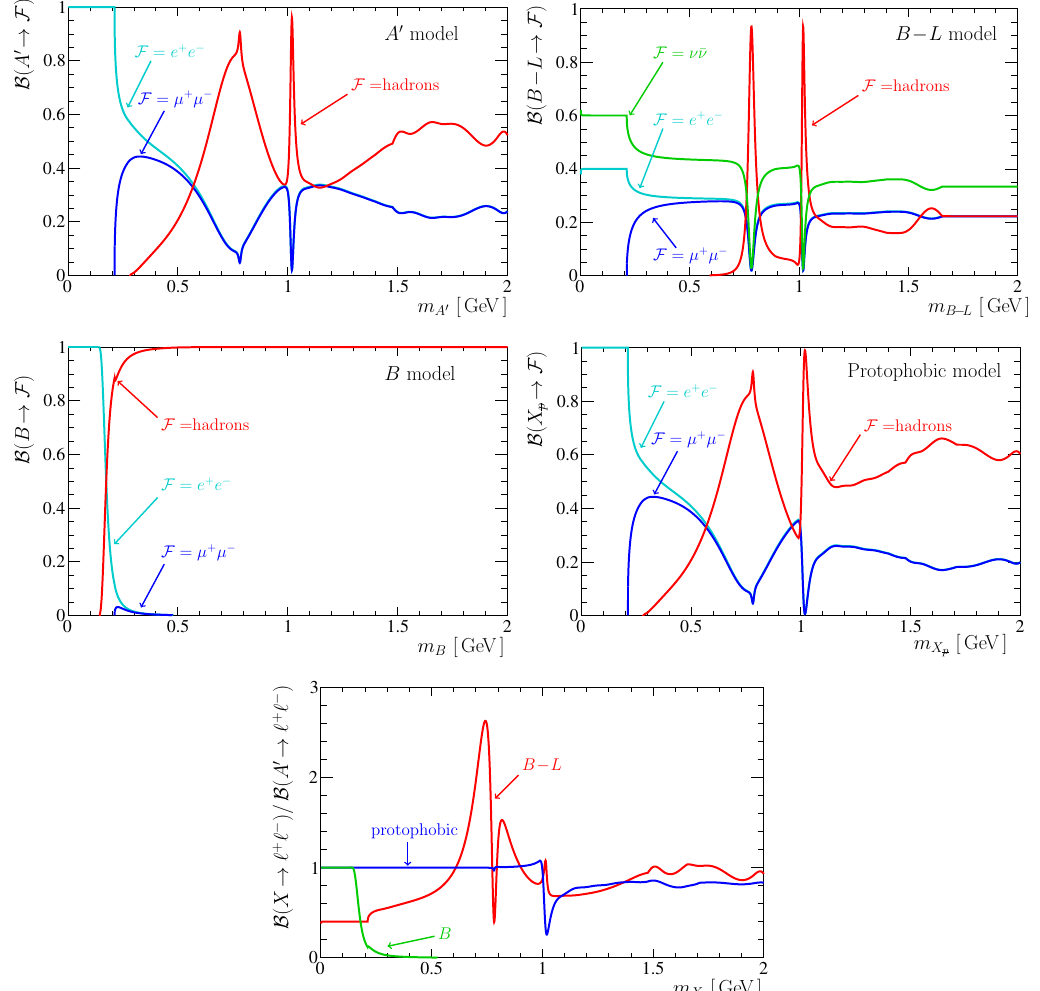
Figure 3 . Decay branching fractions for the (top left) A 0 , (top right) B (middle right) protophobic models. The branching fractions of the B boson decaying into speci(cid:12)c hadronic (cid:12)nal states are shown in (cid:12)gure 10. (bottom) Ratio of the branching fractions to leptons for B L , B , and the protophobic model relative to the A 0 (cid:0)